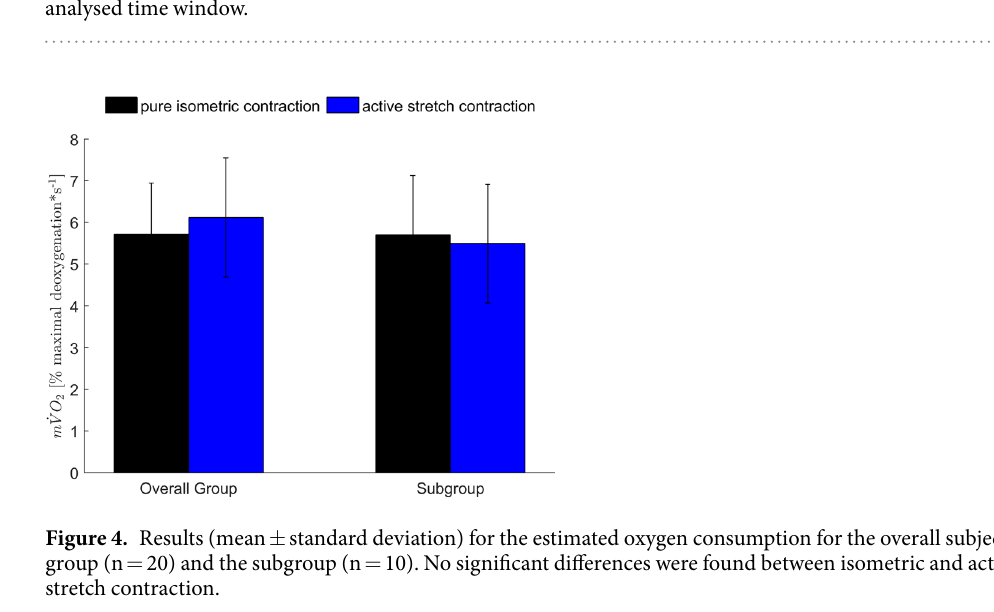
Table 2. Mean and standard deviation ( ± ) of all subjects during pure isometric (iso) and active stretch (as) contractions at T1. T1 = 4–20 s after stretch. Torque = Plantar flexion torque. Angle = Angular position at the anterior. Torque and angle data represent mean data. GM, GL, SOL and TA represent integrated data * TSI _start = Tissue saturation index just prior to the onset of the contraction. ** TSI _stretch = Tissue saturation index just after the end of stretch. Bold numbers represent significant differences between contraction conditions at specific analysed time window.